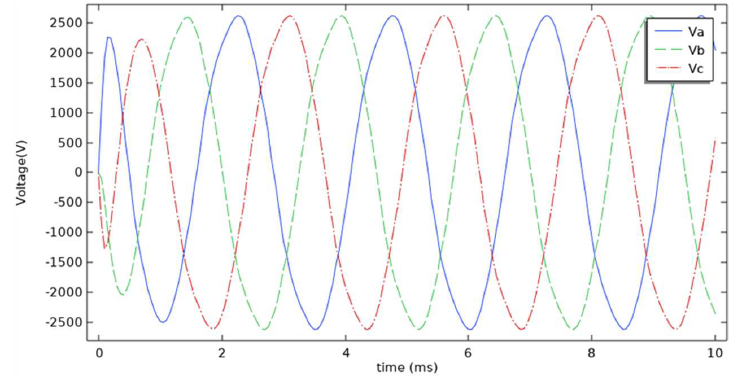
Figure 6. The three-phase stator voltage with load (10 ohms per phase).